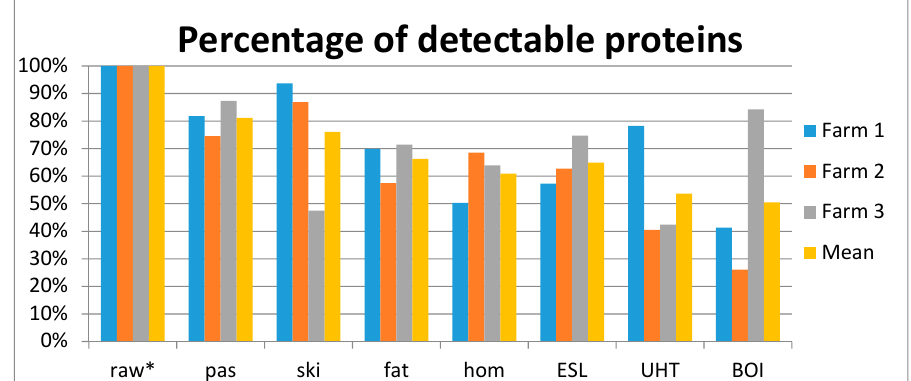
Figure 1. Proportion of number of detectable proteins in milk samples (each sample per farm individually and averaged over the three different samples) after different processing compared to raw cow’s milk. * No. of detectable native proteins in raw milk is the reference, i.e., 151 distinct proteins were detected in the three raw milk samples on average.